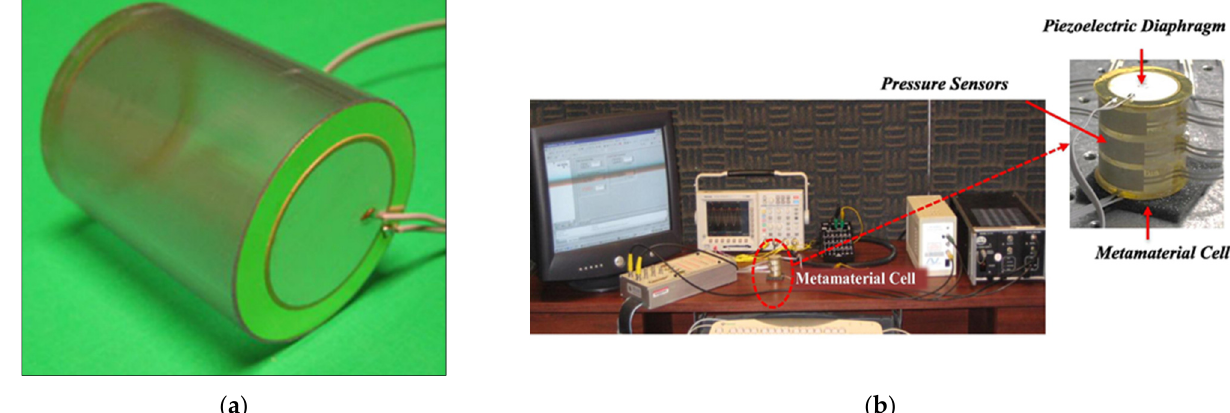
Figure 9 . ( a ) Initial experimental prototype of an active AMM cell comprised of an acrylic cylinder with piezoelectric bimorphs sealing the ends. The volume of the cell is filled with water to act as the transmission medium. The piezoelectric membranes act as both actuators and sensing apparatus; hence they are connected via electrodes to a controller and amplifier (Reprinted from [38], with the permission of AIP Publishing). ( b ) Experimental set-up for an active AMM cell using piezoelectric membranes. A similar but more refined version of the experimental prototype in ( a ), with this example being more compact with additional embedded pressure sensors and closed-loop control [88] (Reprinted from Applied Acoustics, Volume 178, W. Akl and A. Baz., ‘Active control of the dynamic density of acoustic metamaterials’, Copyright (2021), with permission from Elsevier).